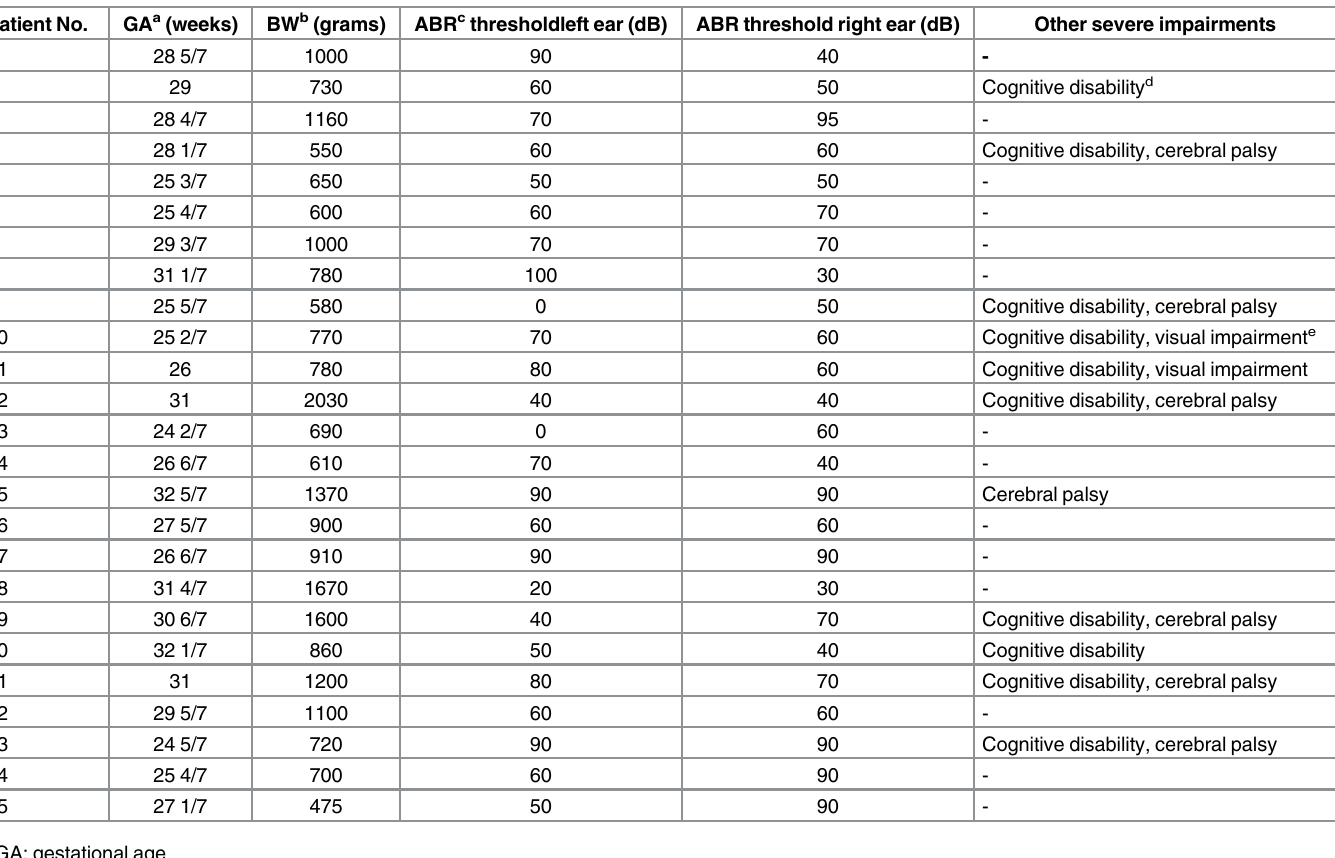
Table 2. Audiologic status and neurodevelopmental outcome in the study group. Patient